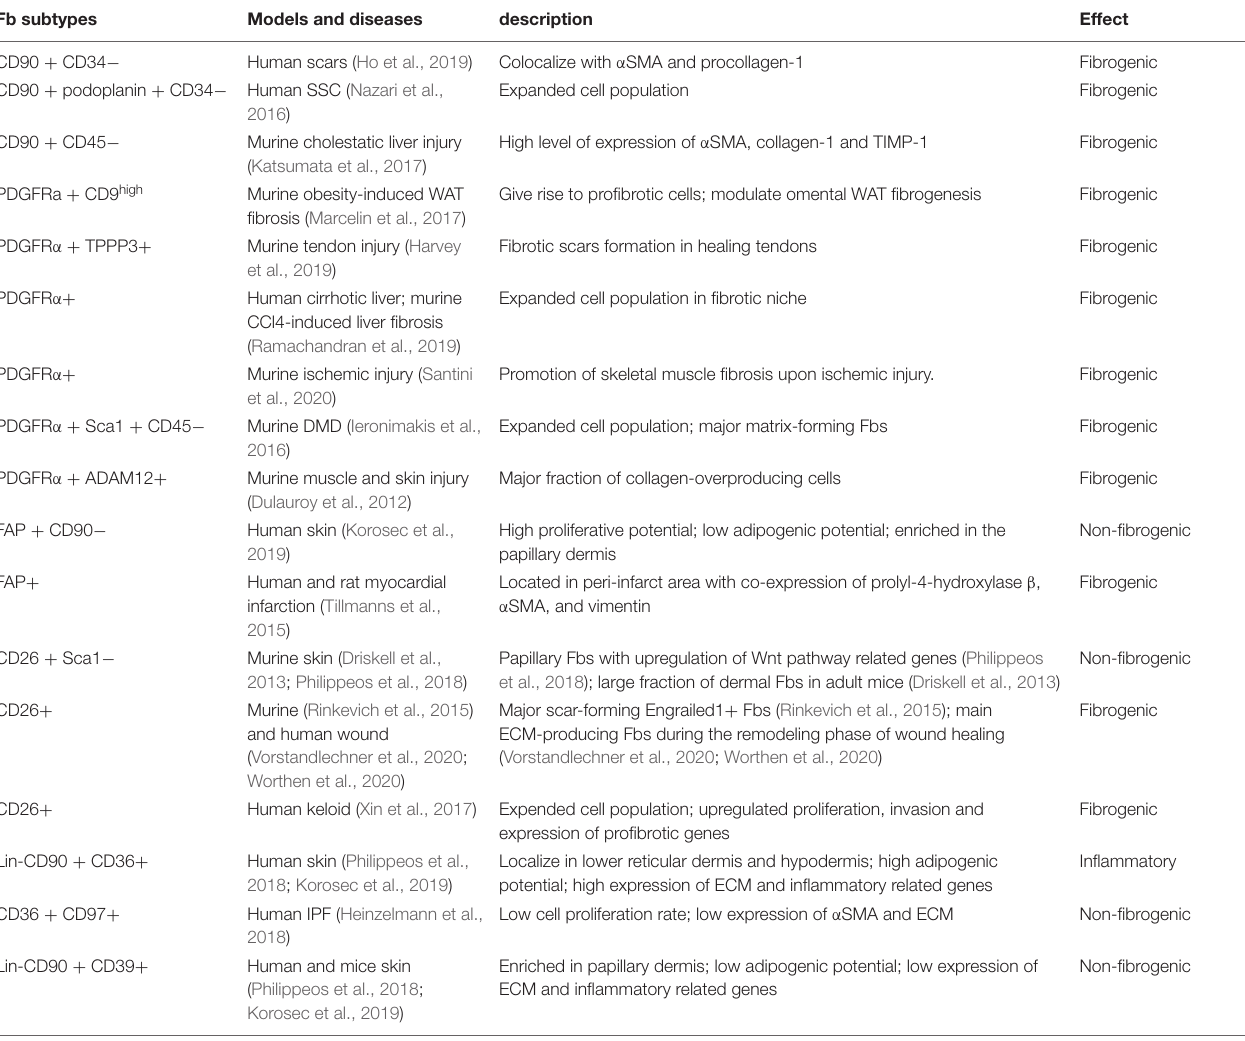
TABLE 1 | The function of Fb subtypes in tissue